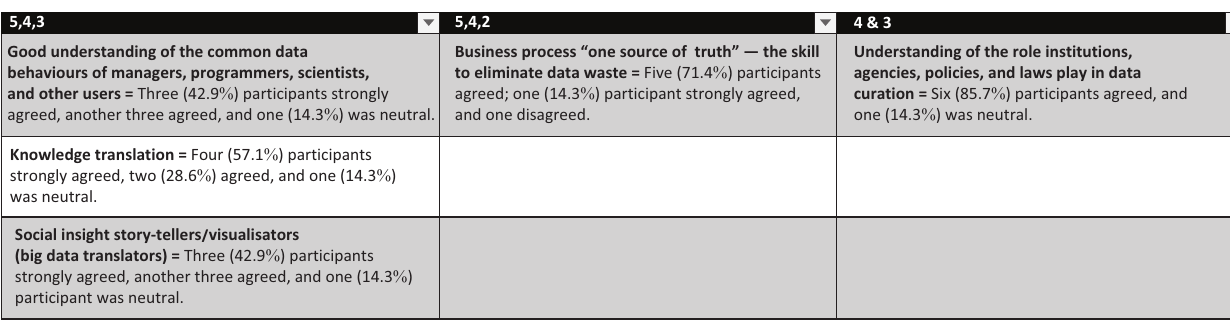
FIGURE 4: Results of data, information and knowledge-related skills with no consensus.